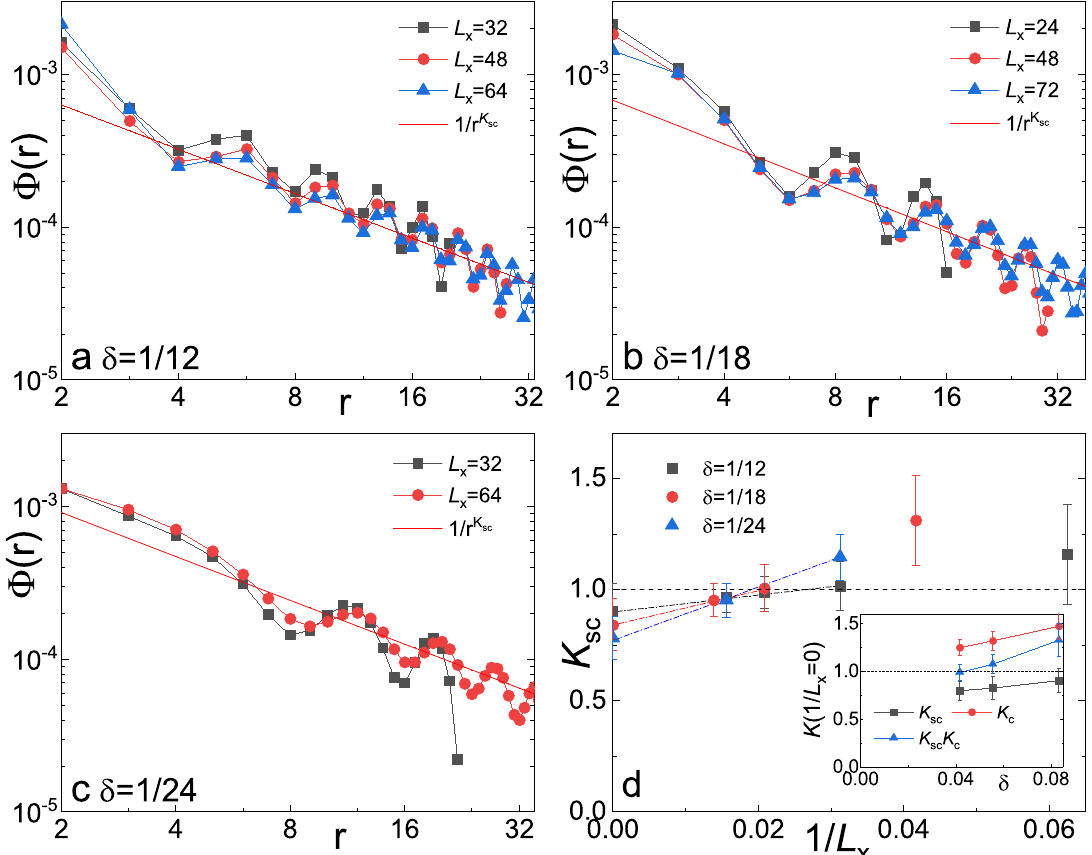
Fig. 4 Superconducting correlations on L y = 6 cylinders. SC correlations Φ aa ( r ) on L y = 6 cylinders of length L x for ( a ) δ = 1/12, ( b ) δ = 1/18, and ( c ) δ = 1/24 on double-logarithmic scales, where r is the distance between two Cooper pairs in the e x direction. The solid lines denote power-law fi tting Φ aa ð r Þ (cid:1) r (cid:3) K sc . d Luttinger exponent K sc as a function of δ and 1/ L x , as well as their extrapolated value in the long cylinder limit 1/ L x = 0, i.e., L x → ∞ . Inset: The extrapolated exponents K sc (1/ L x = 0), K c (1/ L x = 0) in the long cylinder limit 1/ L x = 0 and their product K sc K c as a function of δ . Error bars denote the numerical uncertainty and the dash-dotted lines denote the linear